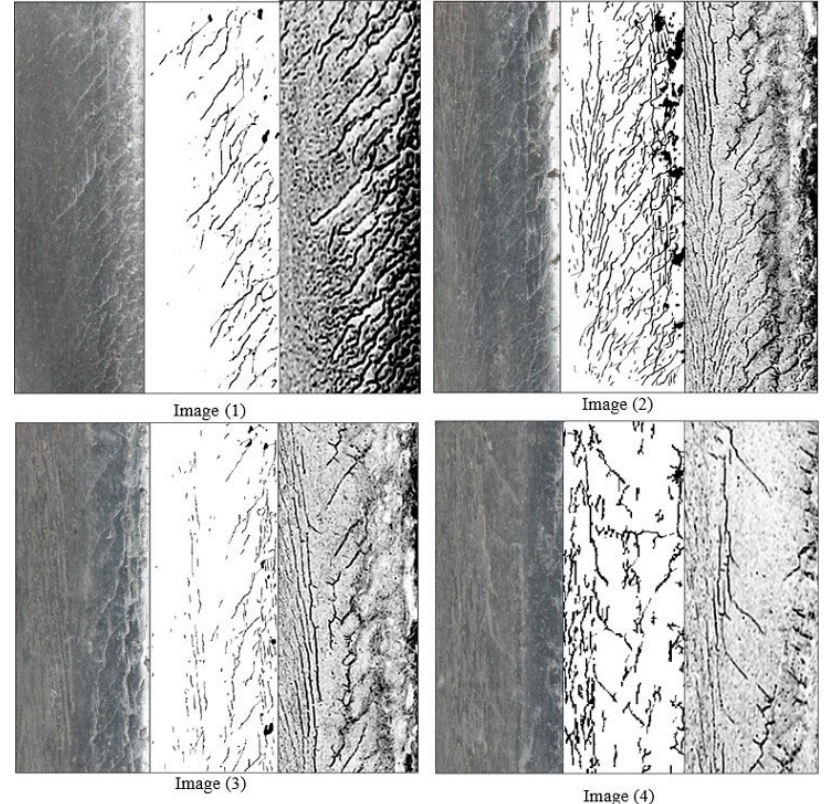
Figure 11. Comparison with MPI in four different sections of rail.